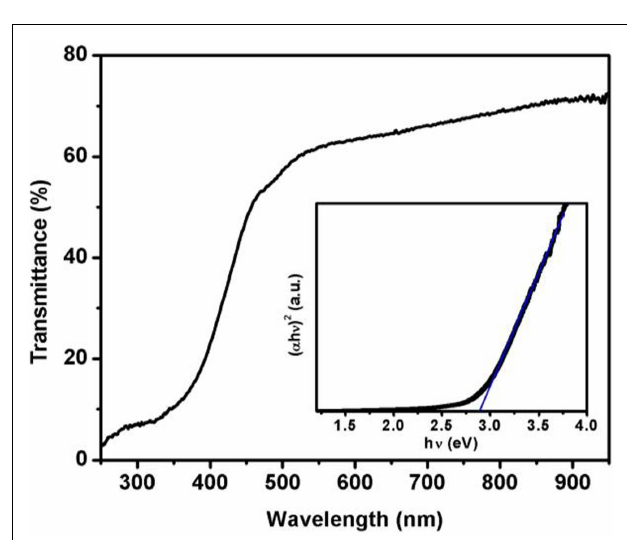
FIGURE 4 | UV–visible spectra of SnFe 2 O 4 film (inset of the figure shows ( α h ν ) 2 vs. h ν plot) .